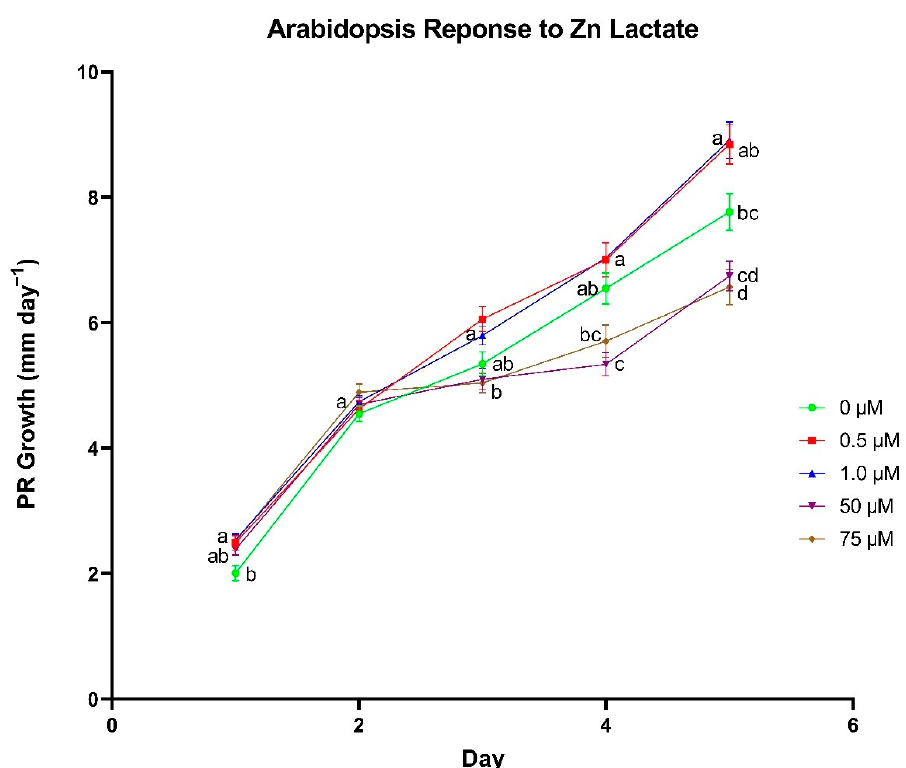
Figure 1. The effect of zinc (Zn) lactate concentration on primary root (PR) growth rate in Arabidopsis thaliana . Differences between means were compared using Tukey’s Honest Significant Difference test, where different letters indicate a statistically significant difference between treatment concentrations in their respective day of growth. Error bars denote means ± SE ( n = 53–78).